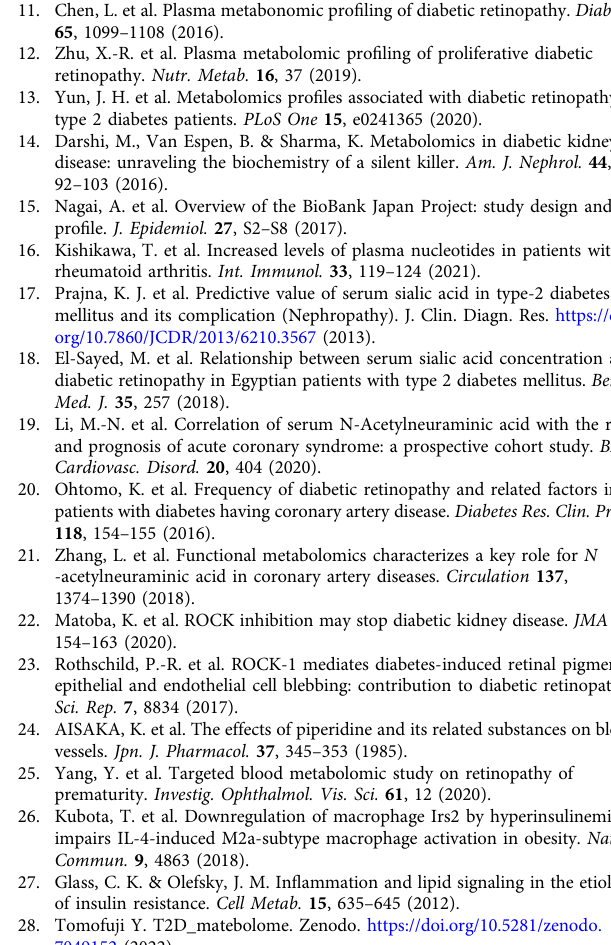
The metabolite abundance data and summary statistics of the logistic regression analysis are available in NBDC Human Database (http://humandbs.biosciencedbc.jp/) with the accession number of hum0372 (note that metabolite abundance data provided by HMT was not raw spectrum data but table data). Source data for the main fi gures in this manuscript are provided as Supplementary Data 1.